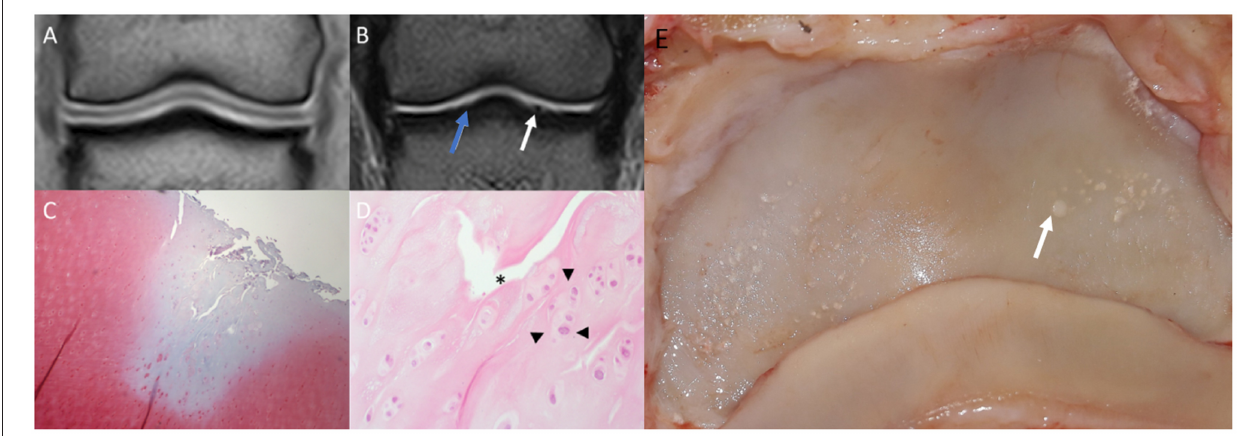
FIGURE 4 | Saline magnetic resonance (MR) images, histology and gross inspection images of the same horse. Lateral is to the left. (A) Dorsal T1-weighted image. Note negative contrast post saline injection as hypointense signal compared to the adjacent hyperintense cartilage signal. (B) Dorsal T2-weighted FSE image. Note the irregular outline (white arrow) of the medial aspect of the articular surface of the distal phalanx (P3). There is a mildly irregular outline of the articular cartilage laterally (blue arrow), which may represent cartilage damage or volume averaging artifact on a curved surface. (C) Safranin-O fast green staining of a macroscopically fibrillated area; the blue discoloration indicates a reduction in proteoglycans. (D) Perpendicular fissures in the superficial cartilage (asterisk) and an abnormal clumping (“chondrones”) of chondrocytes (arrowheads), HE. (E) Gross inspection of the distal phalanx. There are multiple focal cartilage defects medially and laterally. The white arrow corresponds to the white arrow in (B) .